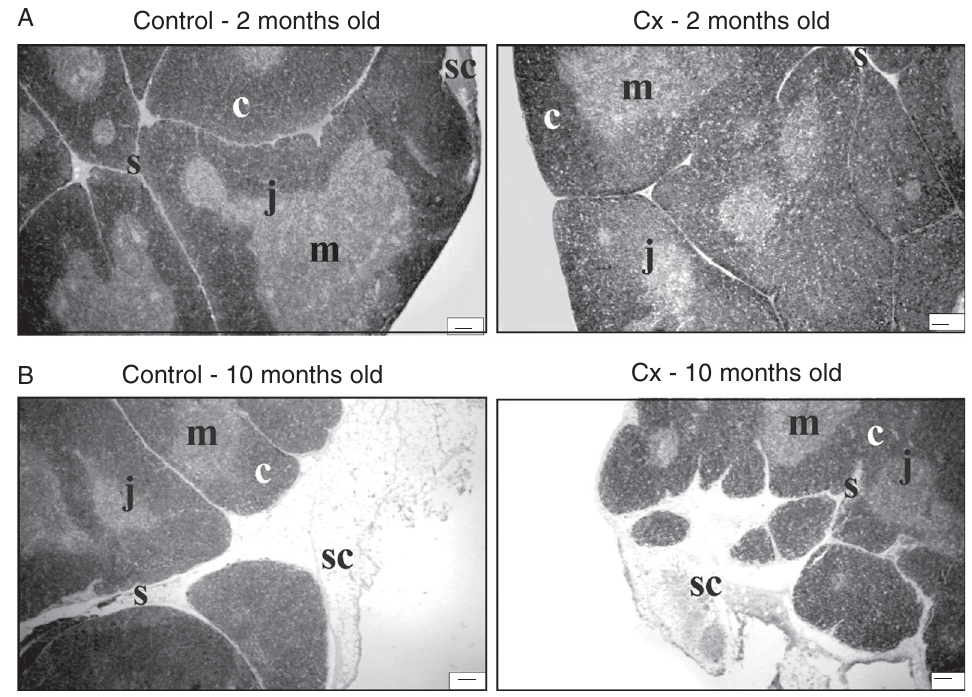
Figure 1. Photomicrographs of thymus sections derived from 2- month-old (A) and 10-month-old (B) controls and rats orchidecto- mized at the age of 30 days (Cx). c = cortex; m = medulla; sc = subcapsular adipose tissue; j = cortico-medullary junction; s = septa; H-E staining, 40X. Bar = 100